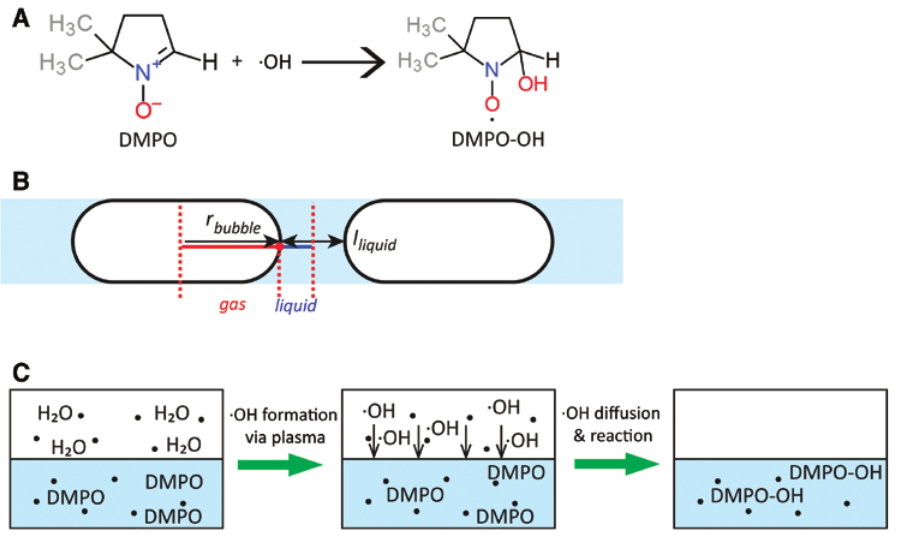
Figure 5: Spin trapping reaction between DMPO and hydroxyl radicals. (A) The chemical equation of the spin trapping reaction; (B) the geometry configuration of the gas/liquid flow; (C) schematic illustation of the spin-trapping